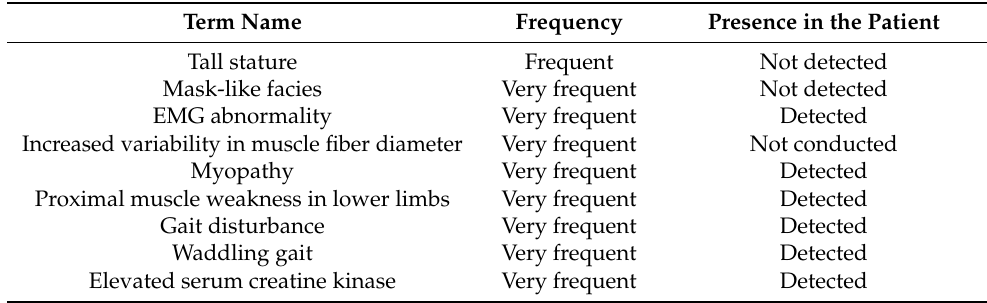
Table 3. Collation of clinical presentation of the Limb-girdle Muscular Dystrophy R8 according to the Human Phenotype Ontology and pathological manifestations in the patient